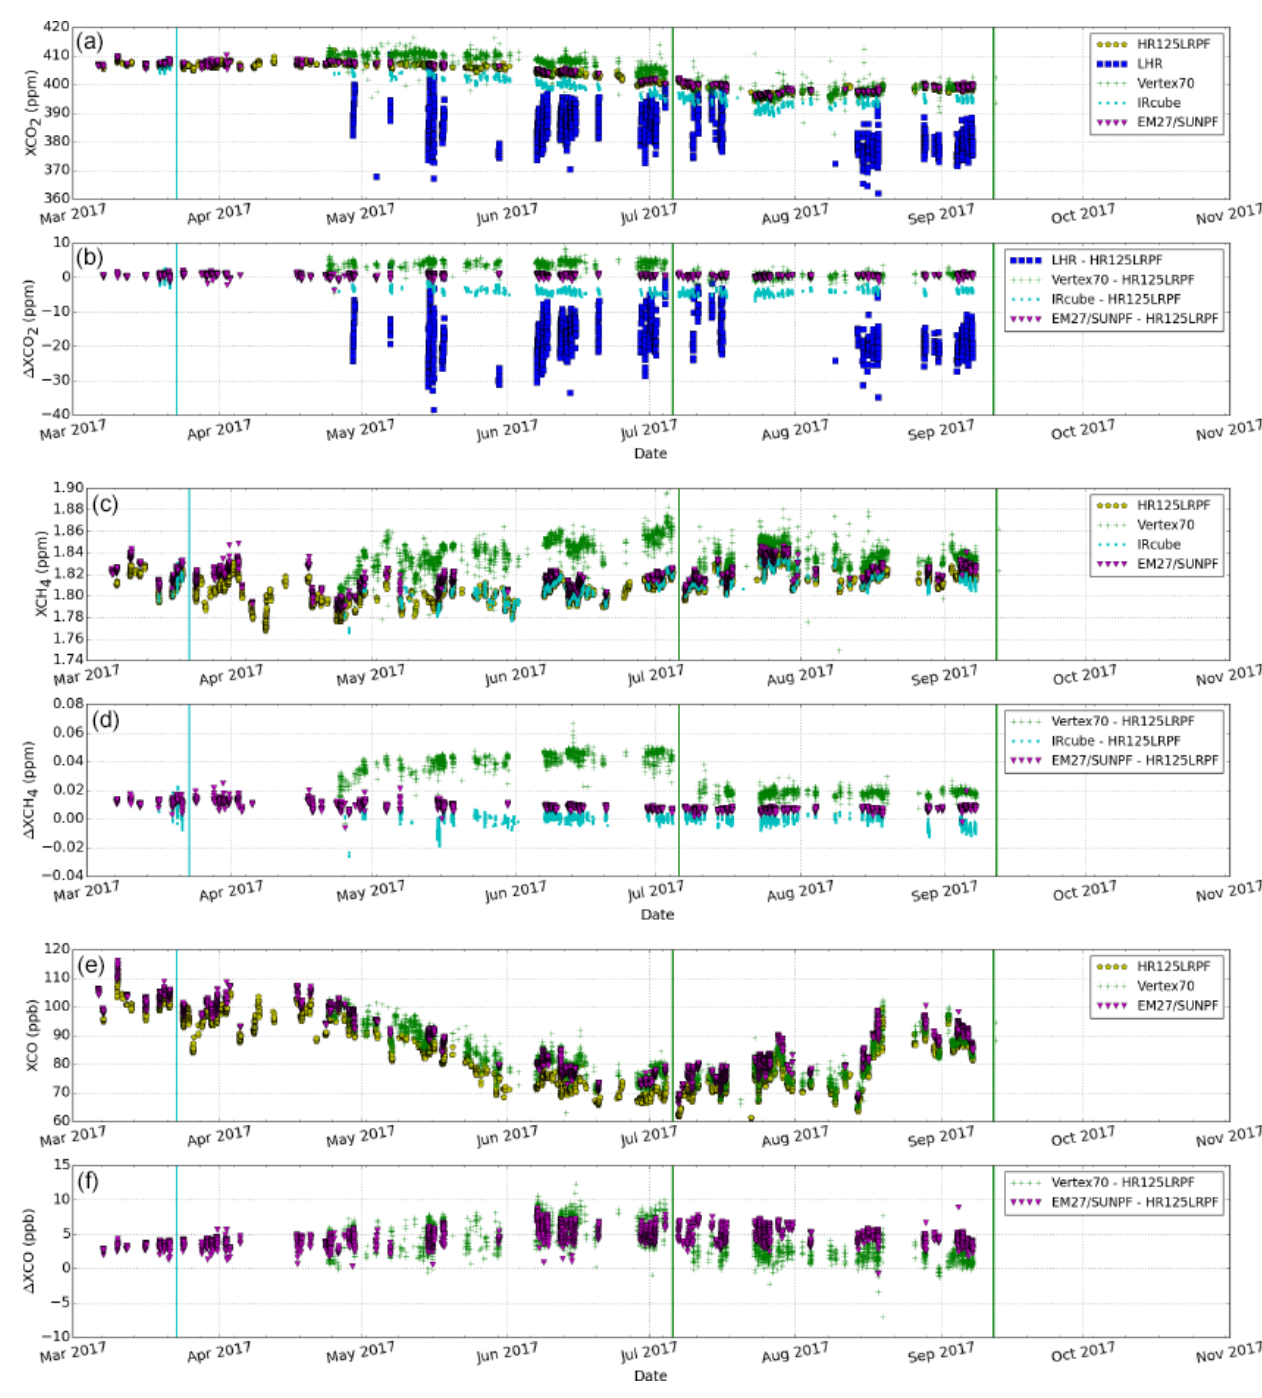
Figure D1. Time series of XCO 2 (a) , XCH 4 (c) , and XCO (e) retrievals for HR125LR, LHR, Vertex70, IRcube, and EM27/SUN using the standard procedure with the TCCON a priori for measurements performed at Sodankylä in 2017. The suffix PF indicates that the retrievals were performed with PROFFAST code. The difference of XCO 2 (b) , XCH 4 (d) , and XCO (f) time series for the test instruments relative to the HR125LR